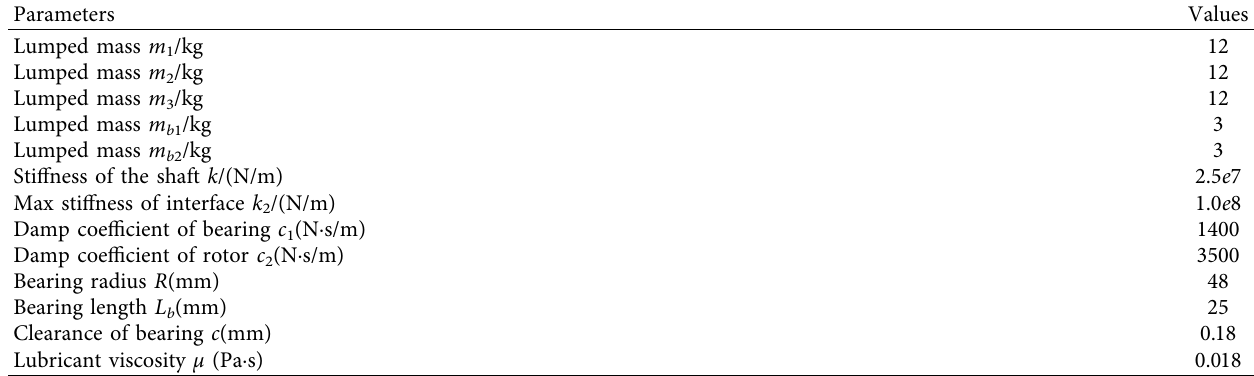
Table 1: Parameters of the rod fastened rotor and bearing.